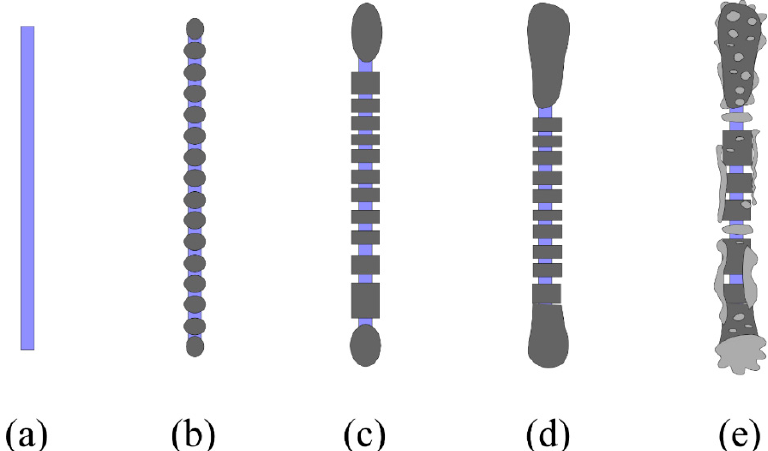
Figure 12. Graphical representation of development of an AB. Mineral fibre is light purple; AB is dark grey; secondary coatings are light grey. ( a ) non-coated fibre; ( b ) first stage of fibre coating, AB appears like a smooth coverage; ( c ) AB evolves developing a segmented structure; ( d ) mature AB with a pearl structure, where the individual segments are well separated from each other. The ends of the fibre are larger than the other segments and sub-rounded; ( e ) some fibres may show multiple coatings.